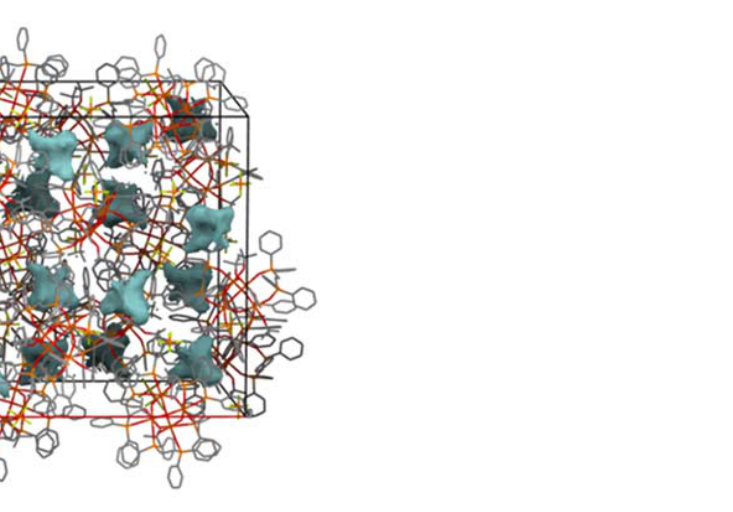
Figure 4. Crystal packing of I with voids (solid shapes) containing disordered Cl − ions. Hydrogen atoms are omitted for clarity.